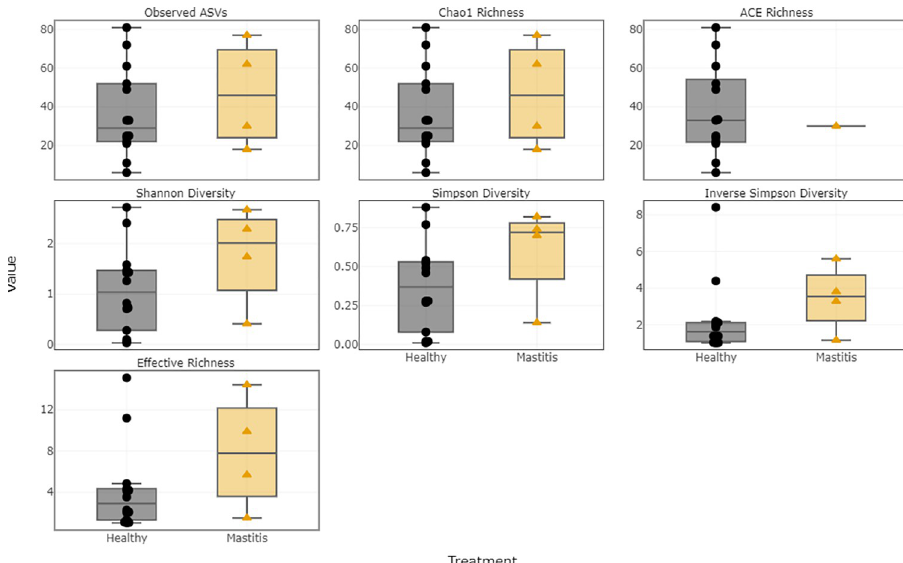
Fig 10. Distribution of alpha diversity measures in relation to sample groups for the